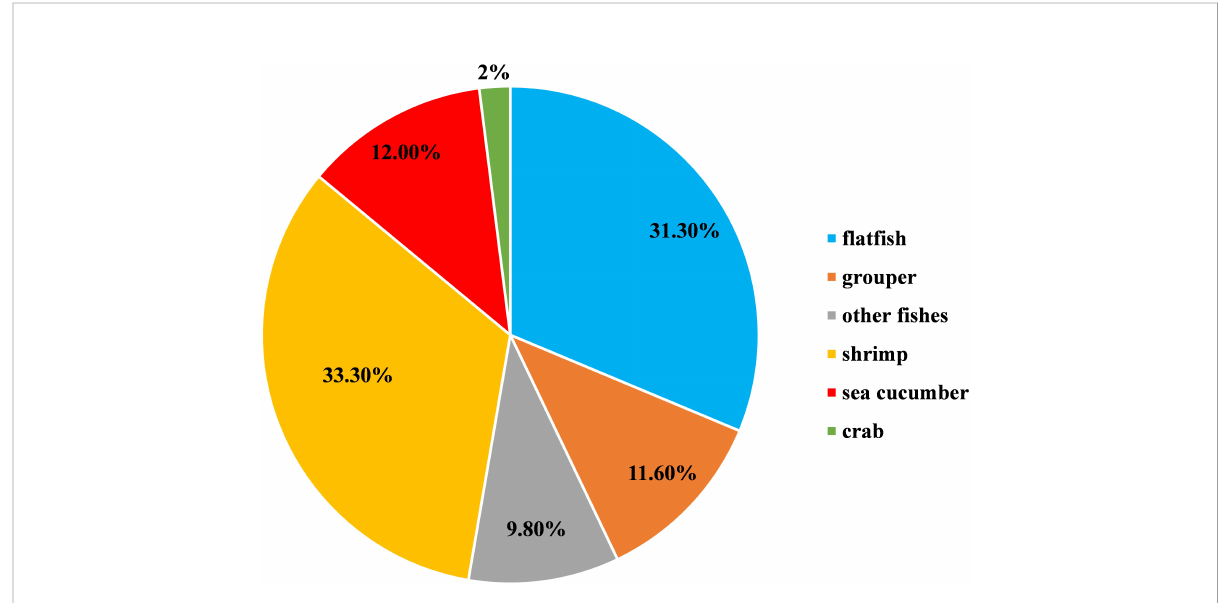
FIGURE 1 Host composition of the 192 Harveyi clade isolates